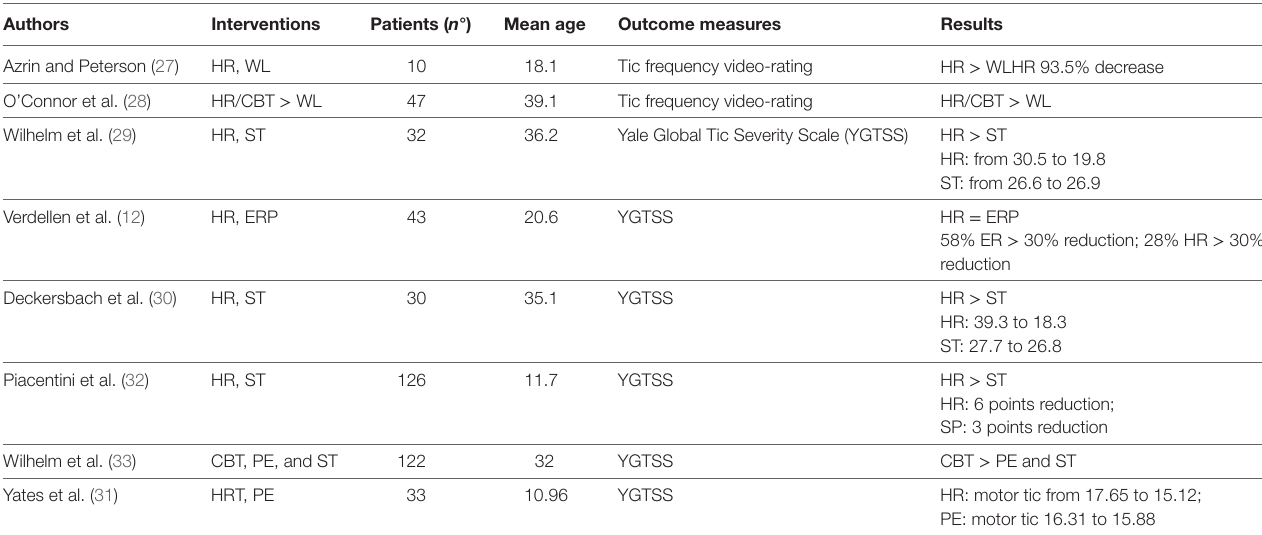
TaBle 1 | Summary of studies on cognitive BT in TS